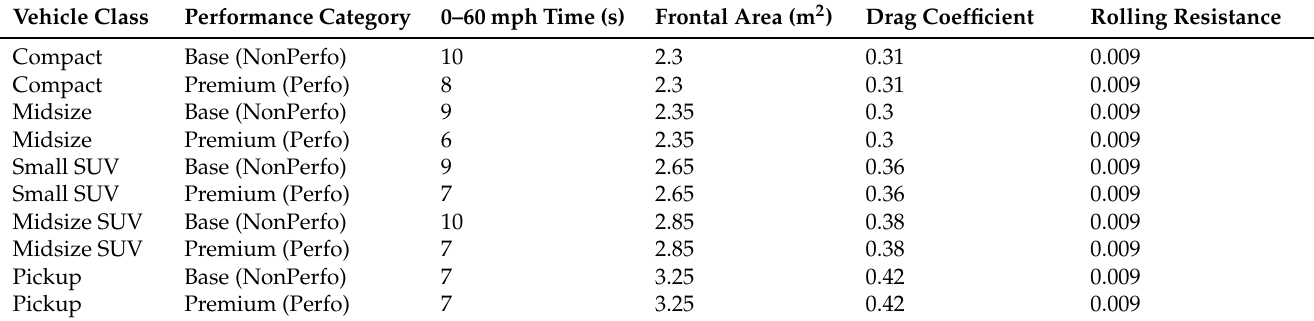
Table 1. Vehicle classification, performance categories, and